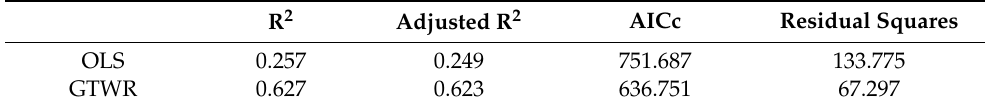
Table 3. Comparison result of OLS and